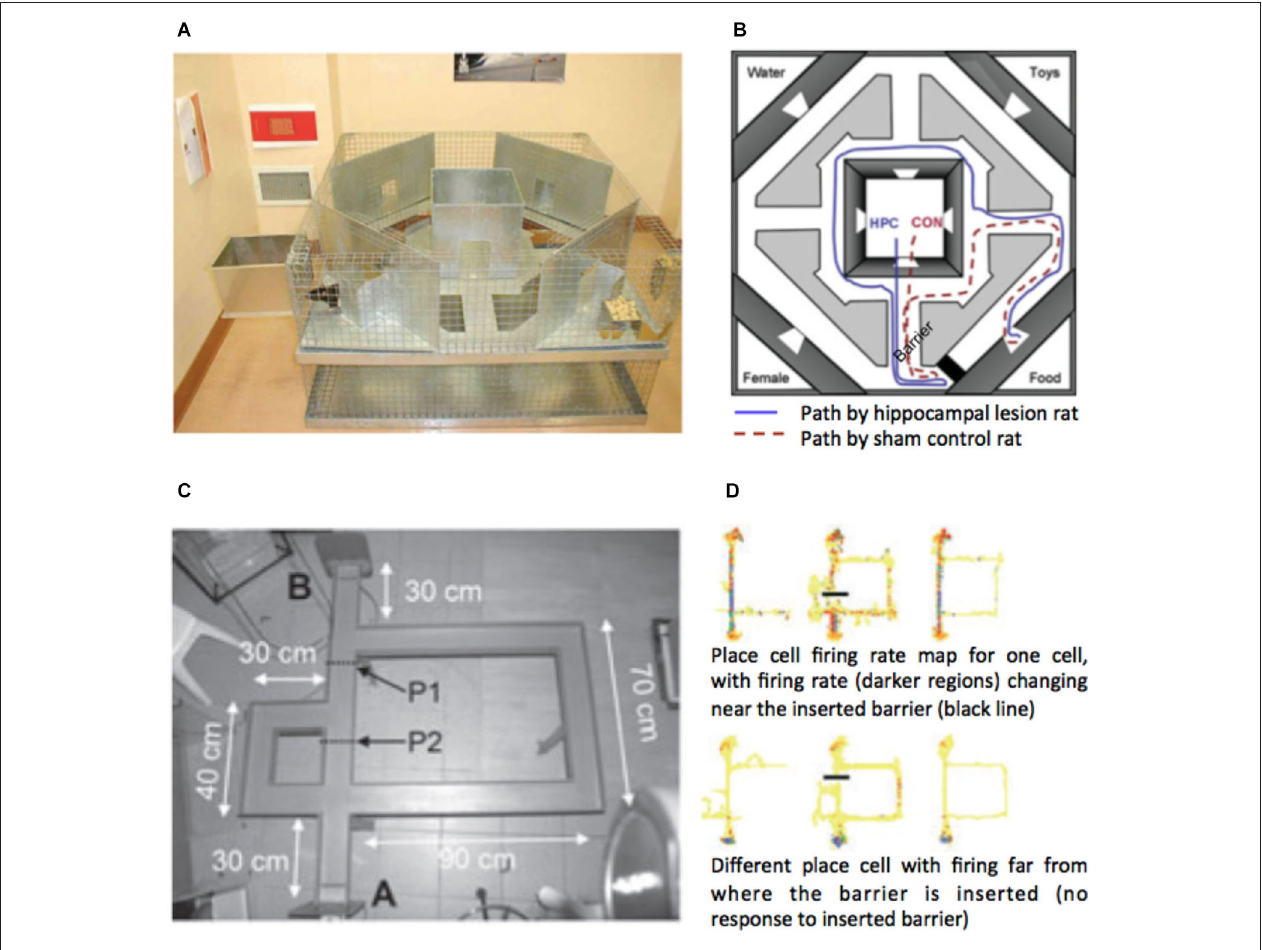
(2011) adapted from Tolman and Honzik (1930). P1 and P2 mark the points where barriers were inserted on different trials. (D) Place cell firing rate maps from two example cells in the study shown before (left), during (middle) and after (right) a barrier has been inserted. Images adapted with